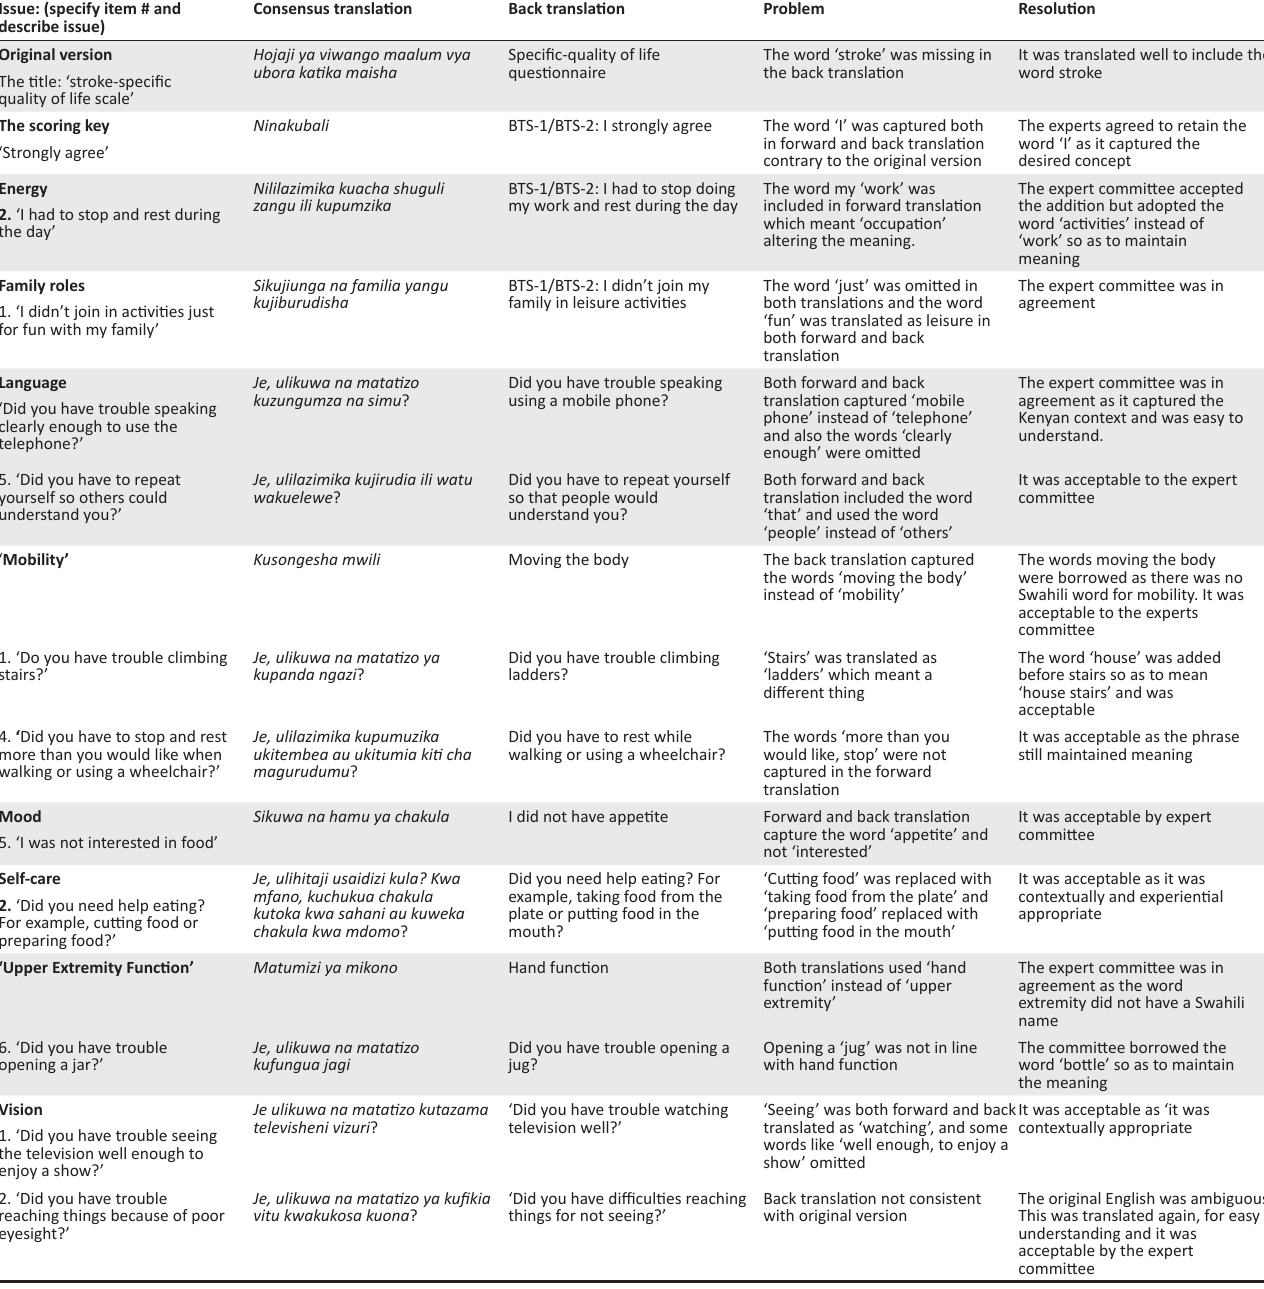
TABLE 2: Expert committee meetings findings on the Swahili version of stroke-specific quality of life scale. Issue: (specify item # and describe